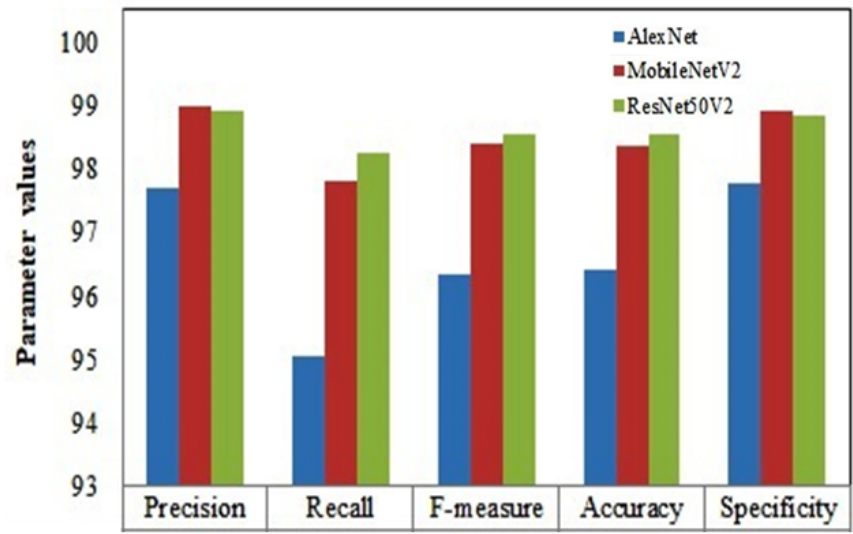
Figure 8. Performance of various parameters in the face mask detection.